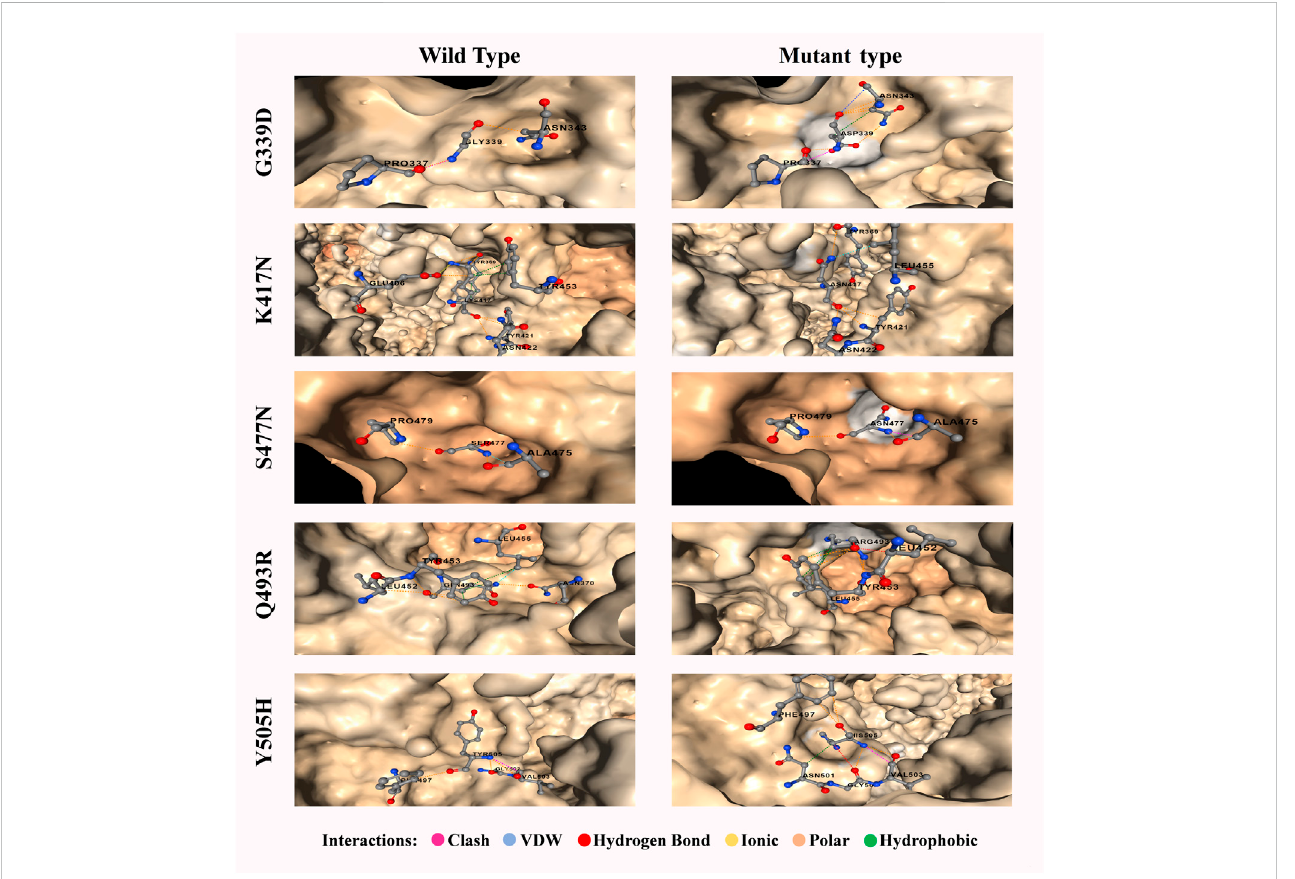
FIGURE 8 Mostsigni fi cant fi vemutationsofspikeproteinsoftheomicronvariantwithacomparativeoverviewofmolecularinteraction.AwildvariantofG339Dhas 1 clash and 2 polar bonds whereas the mutein has an additional 3 polar, 1 hydrophobic and 1 van der waals bonds. Accordingly, wild variant of K417N has 6 polar, 1 ionic and 5 hydrophobic bond whereas the mutein has an additional 2 polar and 1 van der waals bond but lacks ionic and hydrophobic bonds. Wild variant of S477N has 2 polar and 1 van der waals bond whereas the mutein lacks van der waals bond but has an additional 1 clash. Wild variant of Q493R has 6 polar, 1 van der waals, and 3 hydrophobic bond whereas the mutein lacks van der waals bond and 2 polar bonds but has an additional 1 hydrogen bond. Finally, Y505H has 3 polar and 1 clash which results in additional 1 polar, 1 hydrogen, 1 van der waals, and 1 hydrophobic bonds with the lackings of the clash. Clashes are de fi ned as unfavorable interactions where atoms are too close together.